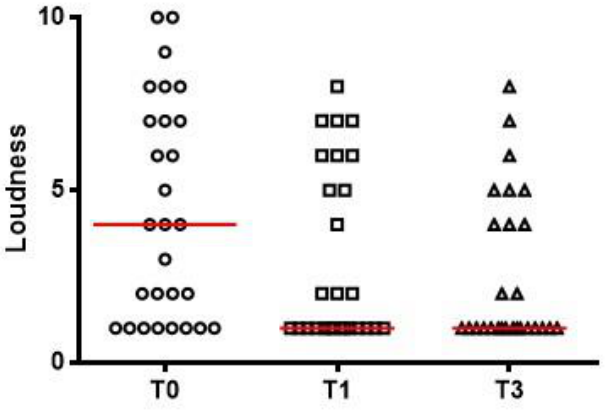
Figure 3. Tinnitus loudness as measured by a visual analog scale before treatment (T0, range 1 to 10, median 4), 1 month after treatment (T1, range 1 to 7, median 1) and 3 months after treatment (T3, range 1 to 7, median 1). Red lines represent median values.